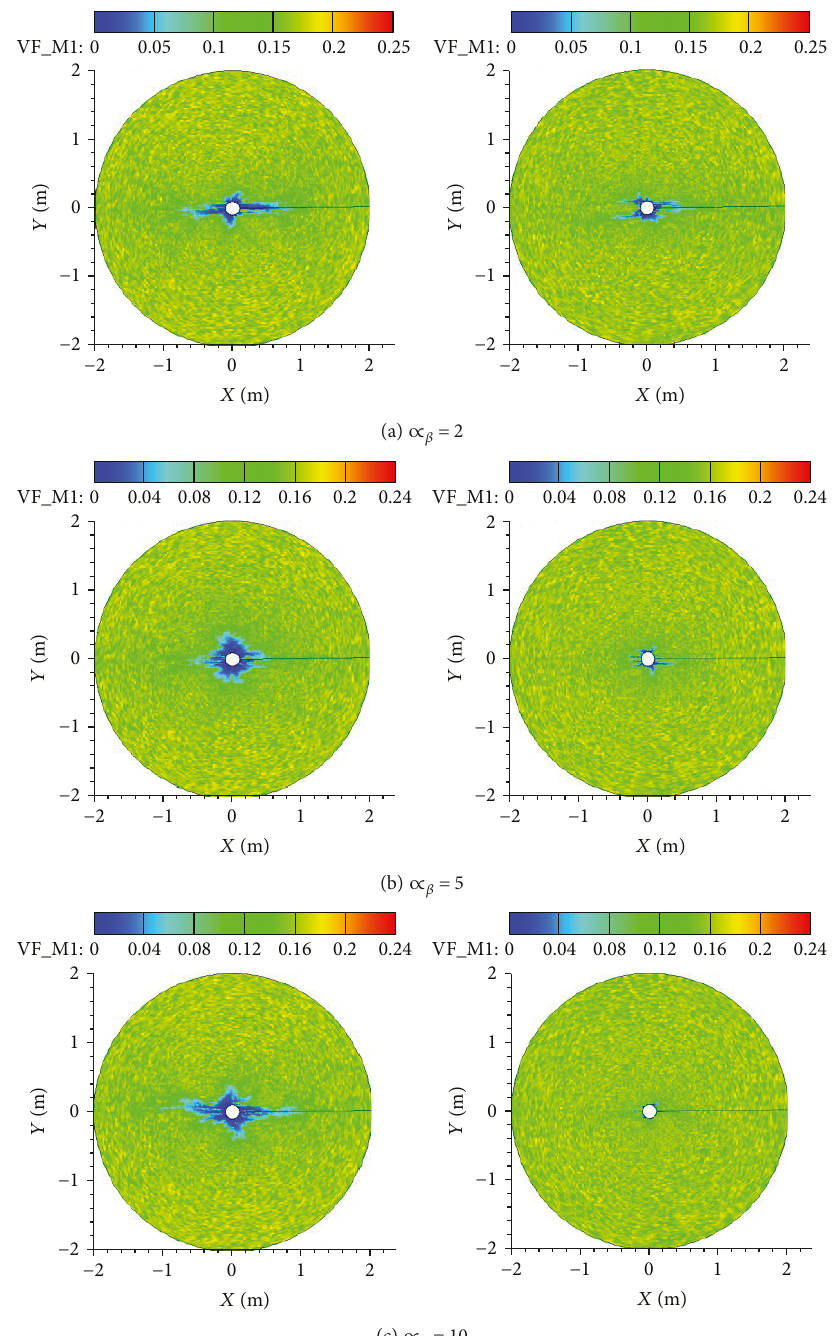
Figure 12: Fast-reacting mineral distribution in two